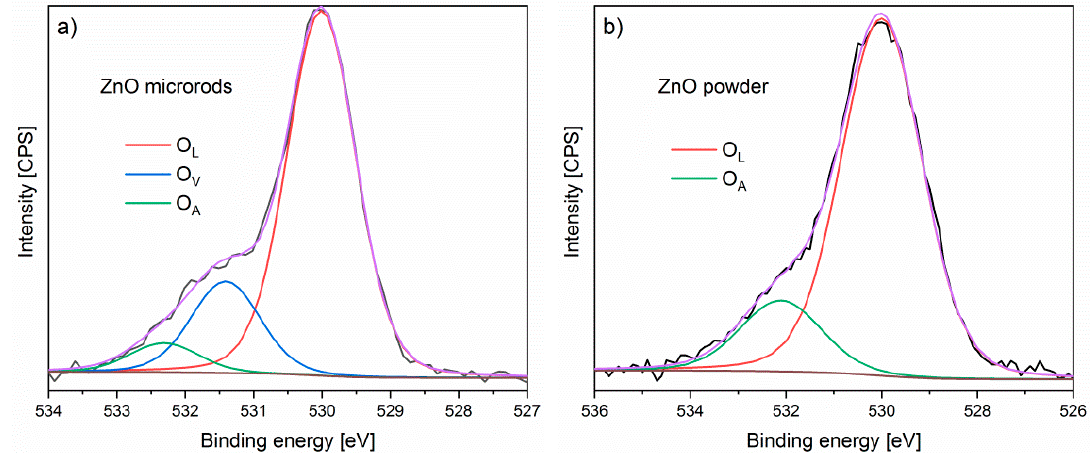
Figure 6. XPS O1s spectral lines after deconvolution of ZnO: ( a ) powder, ( b ) microrods.